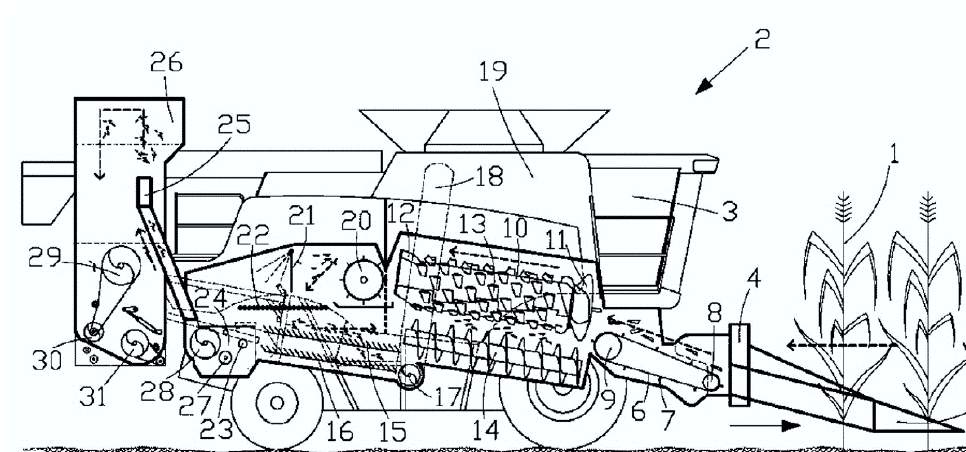
Figure 1. Scheme of the Harcob system for harvesting cobs applied to an axial combine harvester. Reproduced from patent n. EP2668838B1, Racca G. and Racca S. (Current Assignee: Gruppo Racca